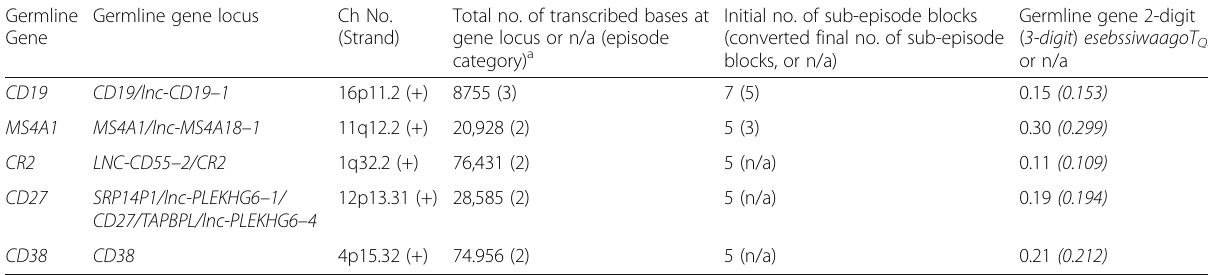
Table 7 (+) strand chromatin CD19 , MSA1 , CR2 , CD27 and CD38 cluster of differentiation receptor gene esebssiwaagoT Q s for pressuromodulation mapping of B-cell differentiation Germline